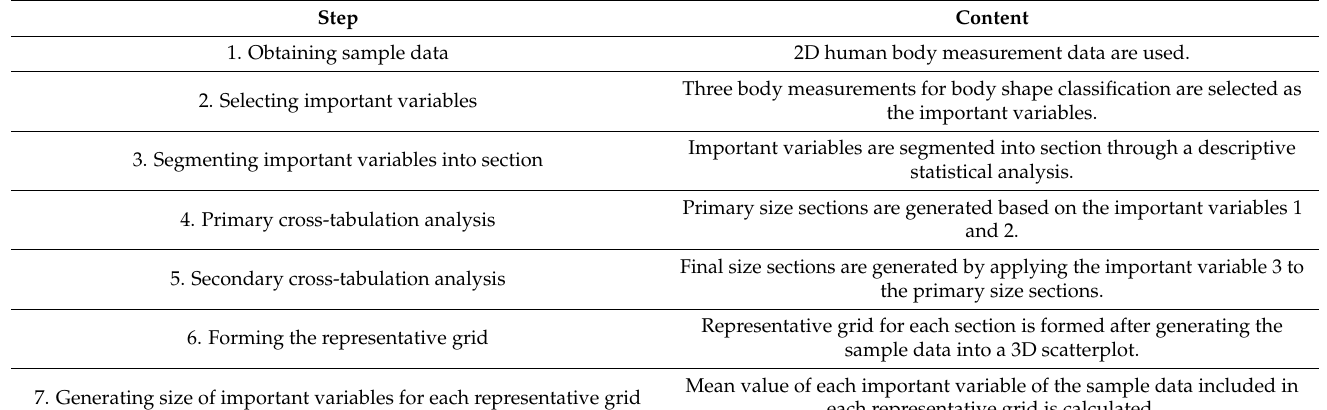
Table 2. Size-section segmentation process.